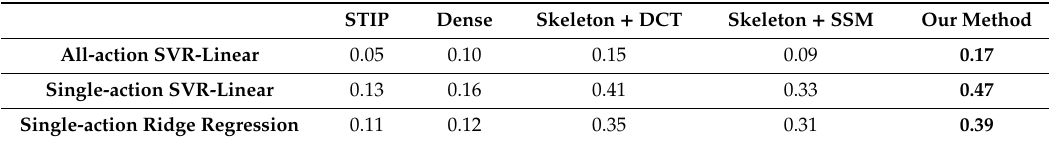
Table 3. Quality assessment results for the UNLV vault dataset. The rank correlation coefficient between the predicted results and the ground truth is presented.